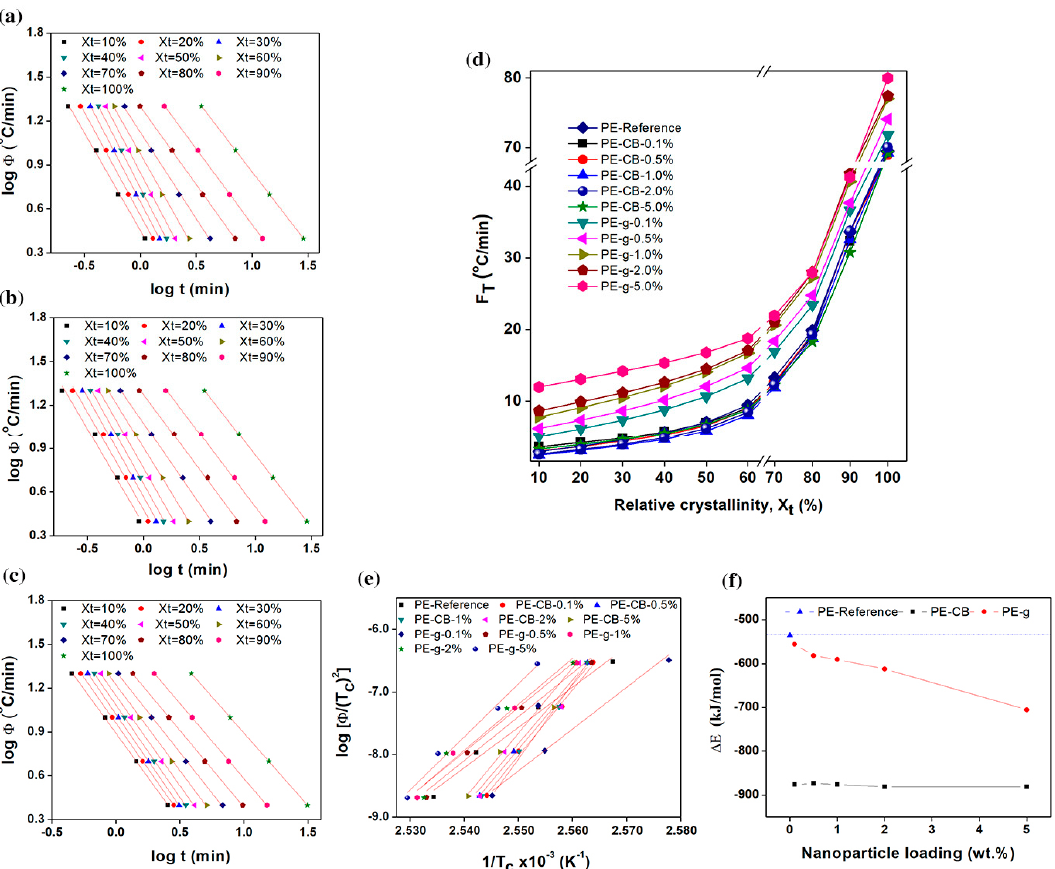
Figure 6. Plots of combined Avrami-Ozawa and H. E. Kissinger equations . Plots of log Φ versus log t from the combined Avrami-Ozawa equations for ( a ) neat multimodal-HDPE, ( b ) PE-CB-1% and ( c ) PE-g-1%, during the non-isothermal crystallisation. ( d ) The kinetic parameter F T as a function of relative degree of crystallinity, for the multimodal-HDPE and its nanocomposites with different nanofiller loadings of 0.1, 0.5, 1, 2, 5 wt.%. Plot of ( e ) log [Φ/(𝑇 (cid:3030) ) (cid:2870) ] versus 1/ 𝑇 (cid:3030) with r 2 > 0.985 and ( f ) ∆ E values as a function of nanoparticle concentration obtained from the H. E. Kissinger equation for the neat multimodal-HDPE, PE-CB and PE-g.